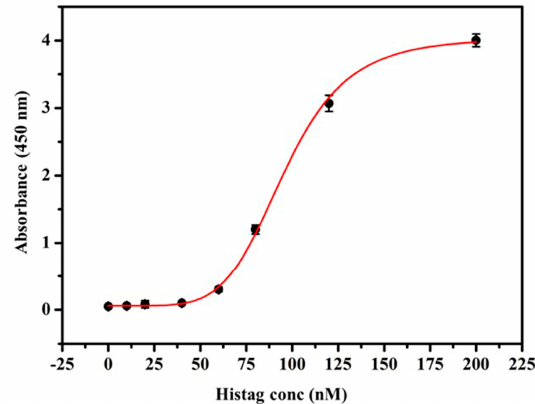
Figure 1. Plot depicting ( a ) the titration of gold nanoparticle with BSA for the binding saturation study, each data point (black dots) represent the error bar, obtained from three sets of experiments.